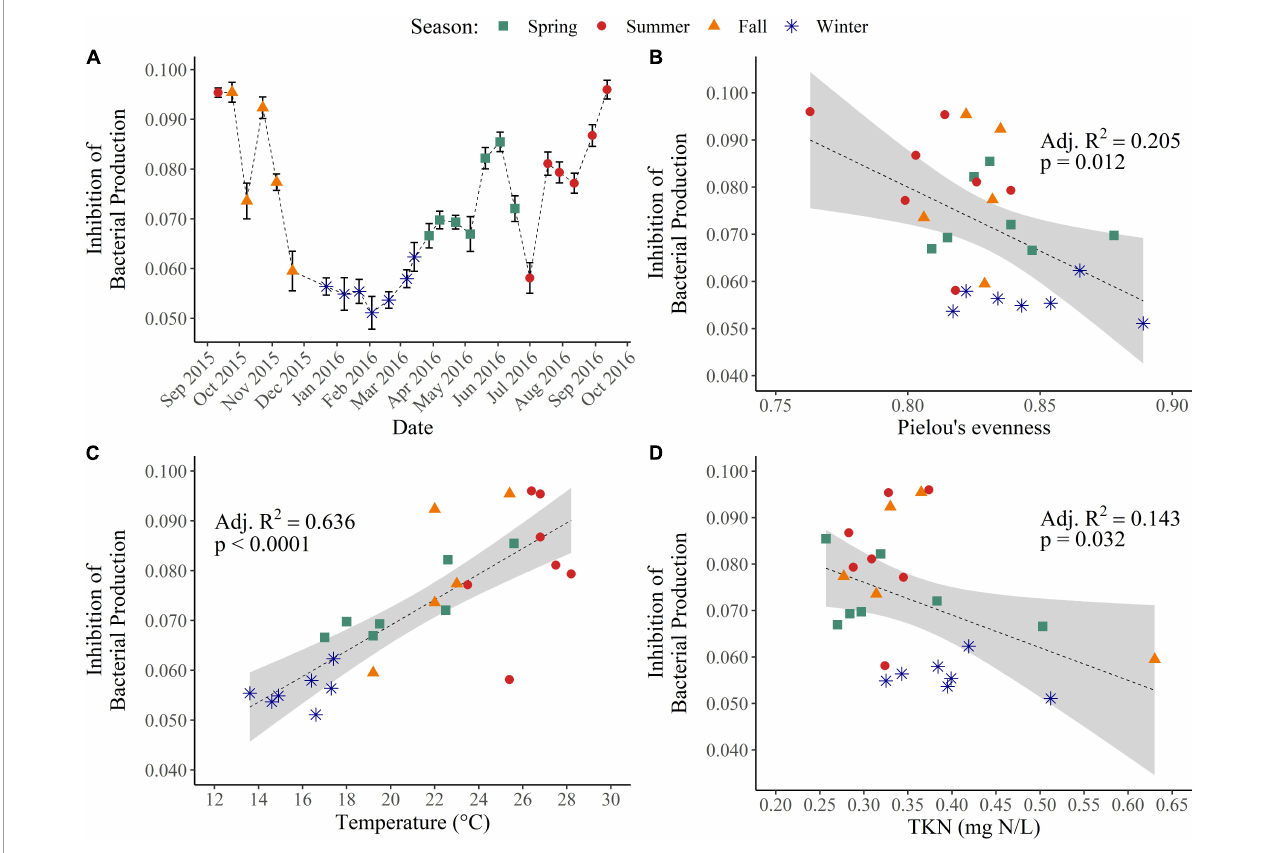
FIGURE5 Inhibition of bacterial production across seasons and environmental drivers. (A) Inhibition of bacterial production was determined through the incorporation of 3 H-leucine along triplicate dose response curves of 0, 0.5, 1, 2.5, 5, and 10% WAF treatment. Linear regression of the inhibition of bacterial production (B) with alpha-diversity, (C) with temperature ( ◦ C), and (D) with total Kjeldahl nitrogen (mg